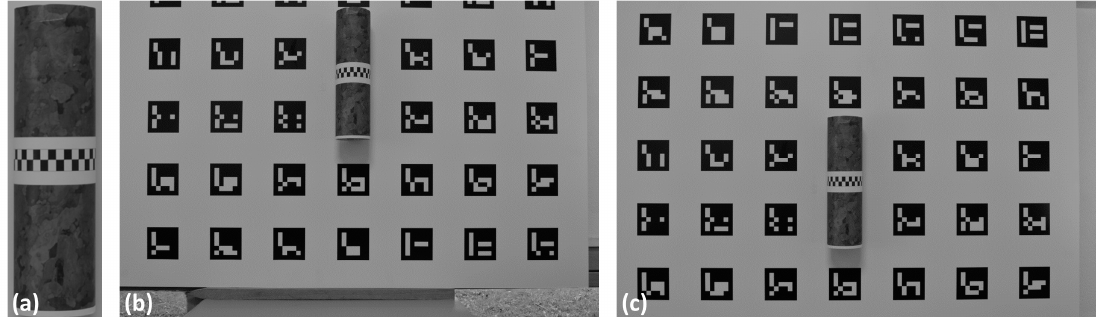
Figure 4. ( a ) Cylinder with a speckle pattern and with a strip covering its circumference. Two images taken from two different heights are shown in ( b ) and ( c ), considering that the cylinder was fixed on the calibration panel.